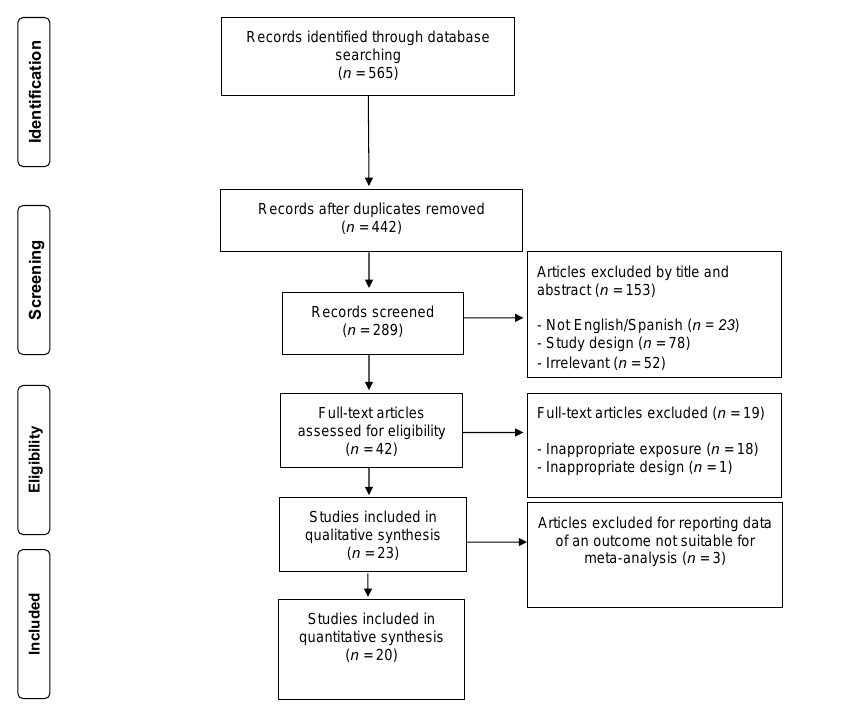
Figure 1. PRISMA flow diagram of literature search and study selection. Table 1. Characteristics of the